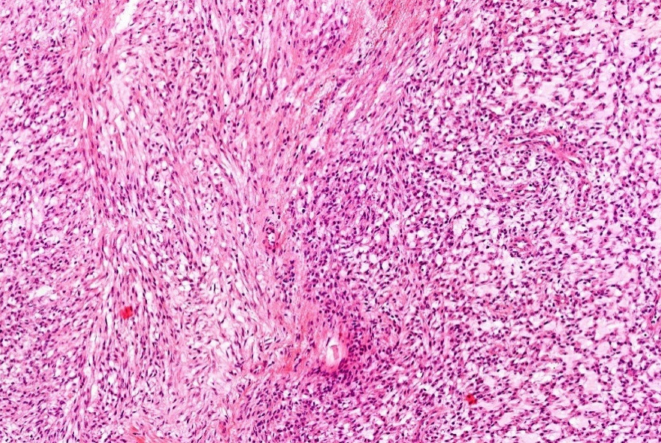
Figure 13. Extraskeletal myxoid chondrosarcoma shows a lace-like architecture due to the myxoid matrix. There are monomorphic epitheloid and spindle cells with an obvious eosinophilic cytoplasm (HE; 20 ×